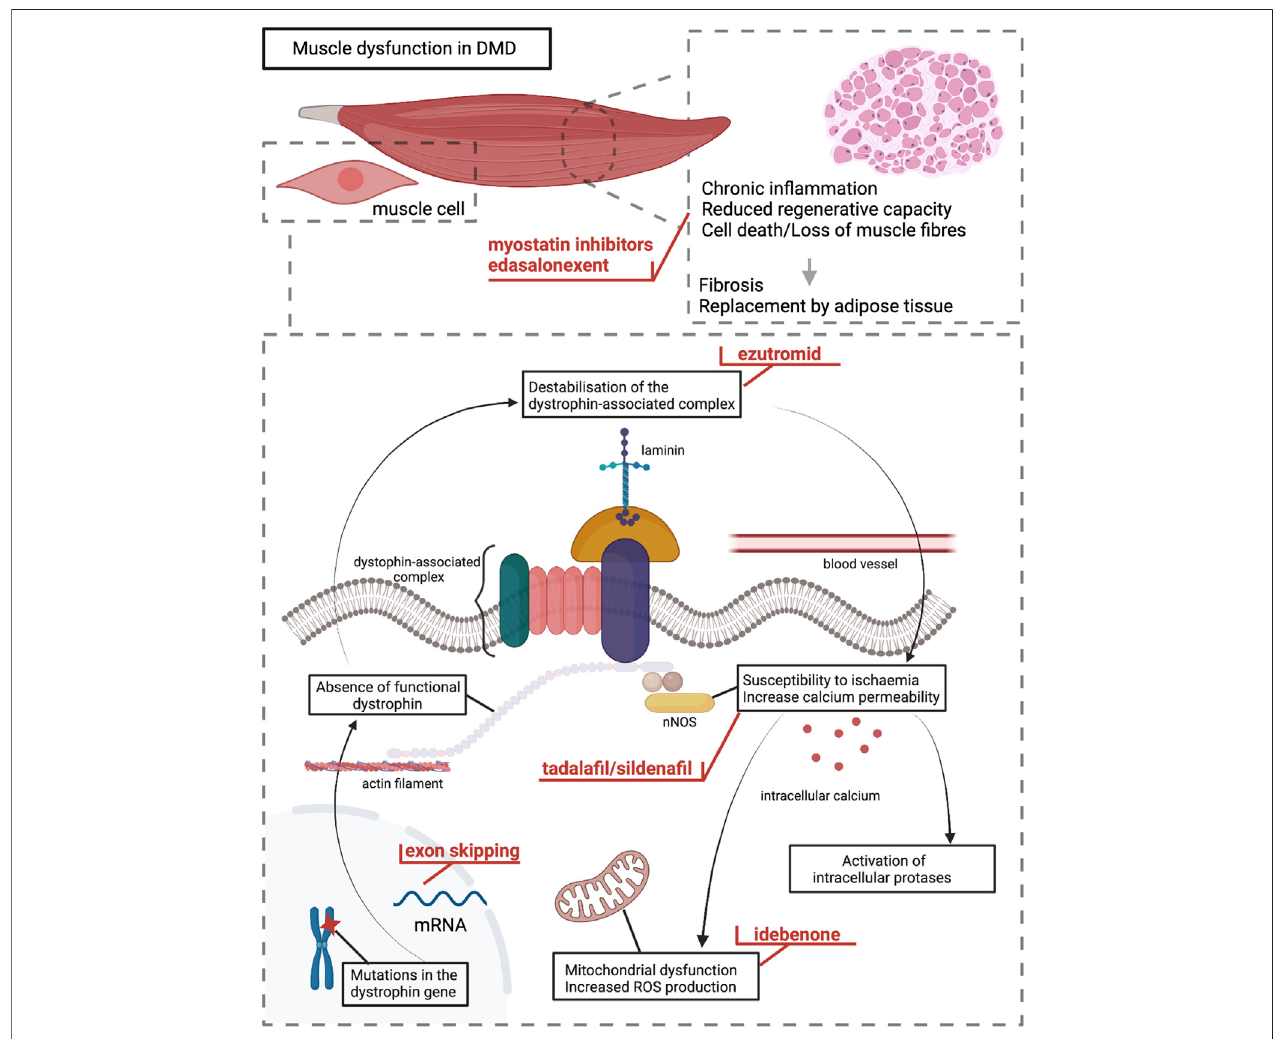
FIGURE 1 | DMD pathophysiology and levels of action for the different compounds discussed in the paper. Mutations in the dystrophin gene lead to absence of functional dystrophin protein in muscle cells and destabilisation of the dystrophin-associated complex at the sarcolemma. This leads to increased susceptibility of the membrane to mechanical stress and ischaemia leading to increased membrane permeability, disturbed cellular signalling, and higher intracellular calcium levels causing activation of intracellular proteases. Mitochondrial dysfunction and increased production of reactive oxygen species contribute to DMD pathophysiology. These trigger a cycle of cell necrosis, chronic in fl ammation, and decreased muscle regenerative capacity. Ultimately, muscle fi bres are lost and replaced by connective and adipose tissue resulting in muscle dysfunction. The different levels of action for the compounds discussed in the paper are indicated in red colour.